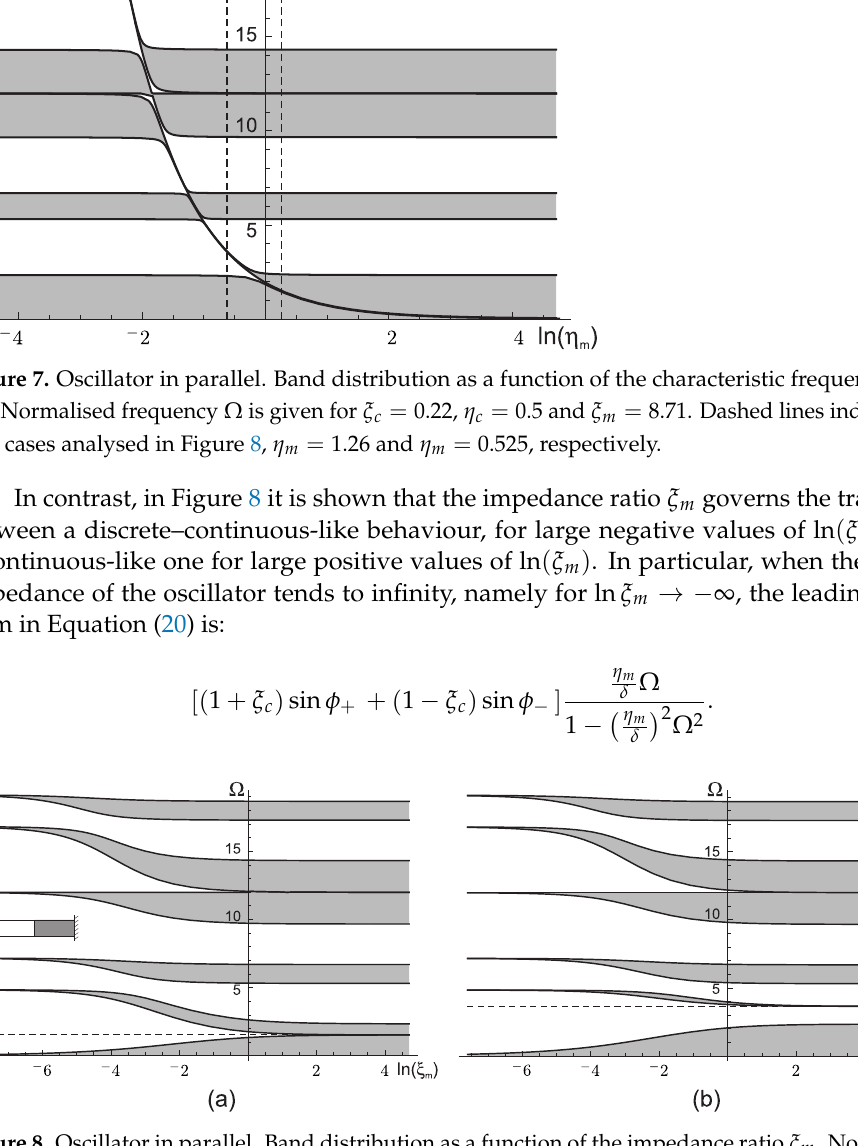
Figure 8. Oscillator in parallel. Band distribution as a function of the impedance ratio ξ m . Normalised frequency Ω is given for ξ c = 0.22 and η c = 0.5. ( a ) η m = 1.26, ( b ) η m = 0.525. Dashed lines indicate the characteristic frequency of the